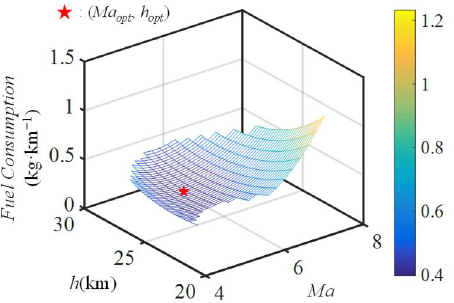
Figure 7. The location of optimal cruise point in the contour of fuel consumption.